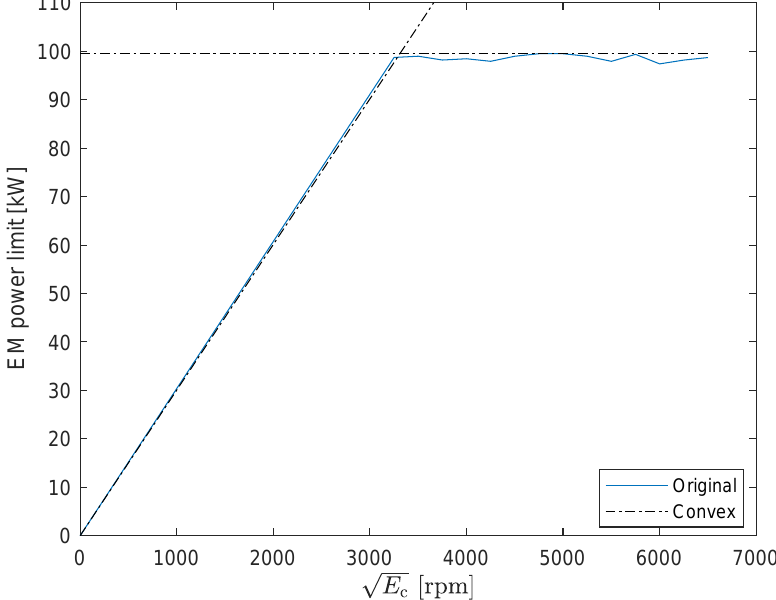
Figure 11. Convex EM power limitation model for s τ = 1 in motoring mode ( P m ). The dash-dot lines represent the approximated convex model before and after the base